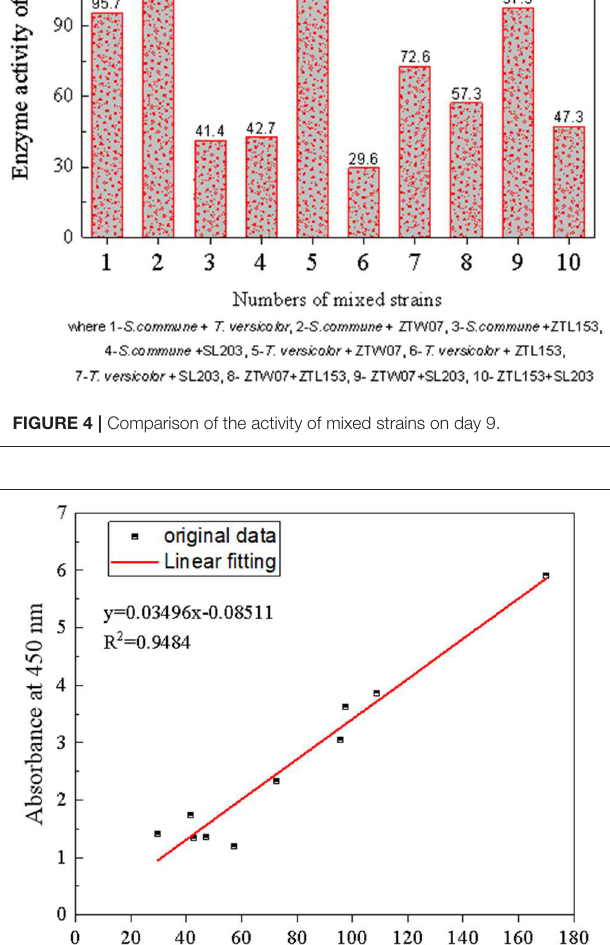
and T. versicolor , were selected, and two strains of the five were